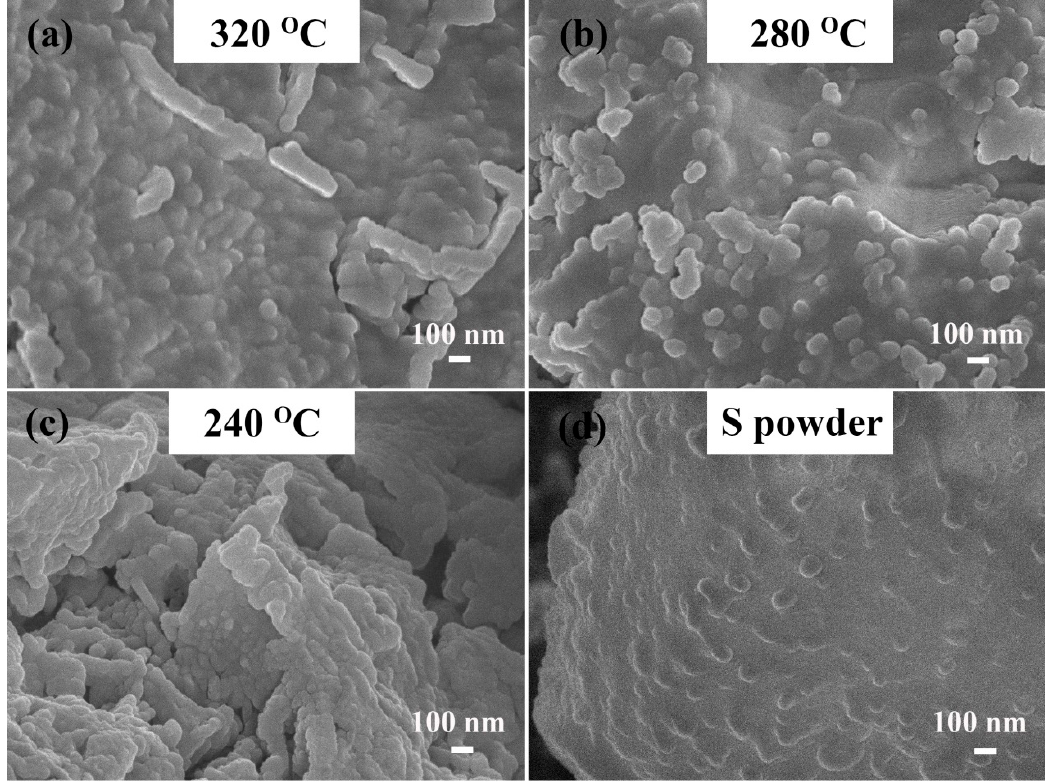
Figure 3. SEM images of commercial sublimed sulfur power and the polymeric sulfur prepared at different temperatures for 4 min ( a ) 320°C; ( b ) 280°C; ( c ) 240°C; ( d ) room temperature.